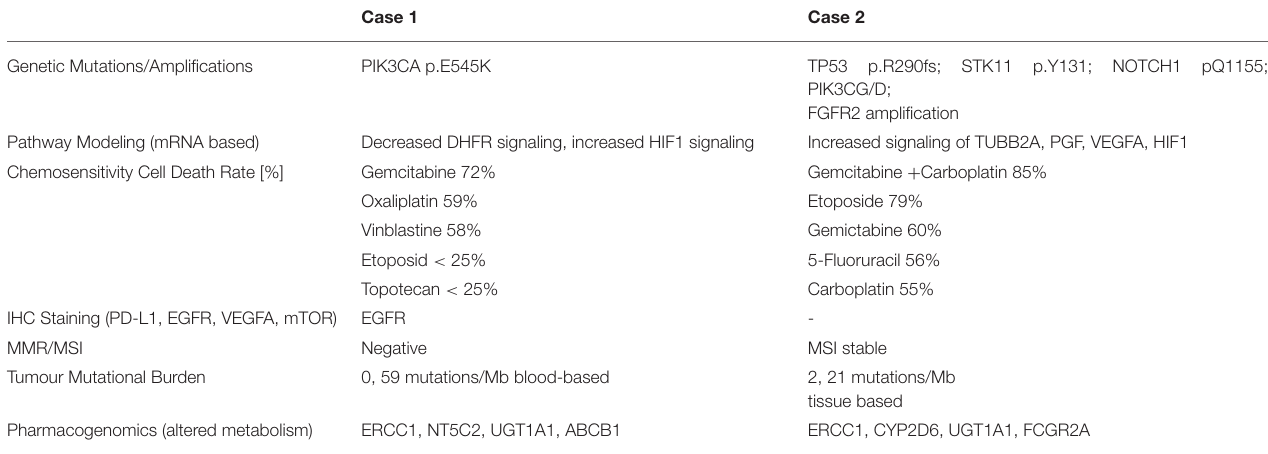
TABLE 1 | Main results of the tumor